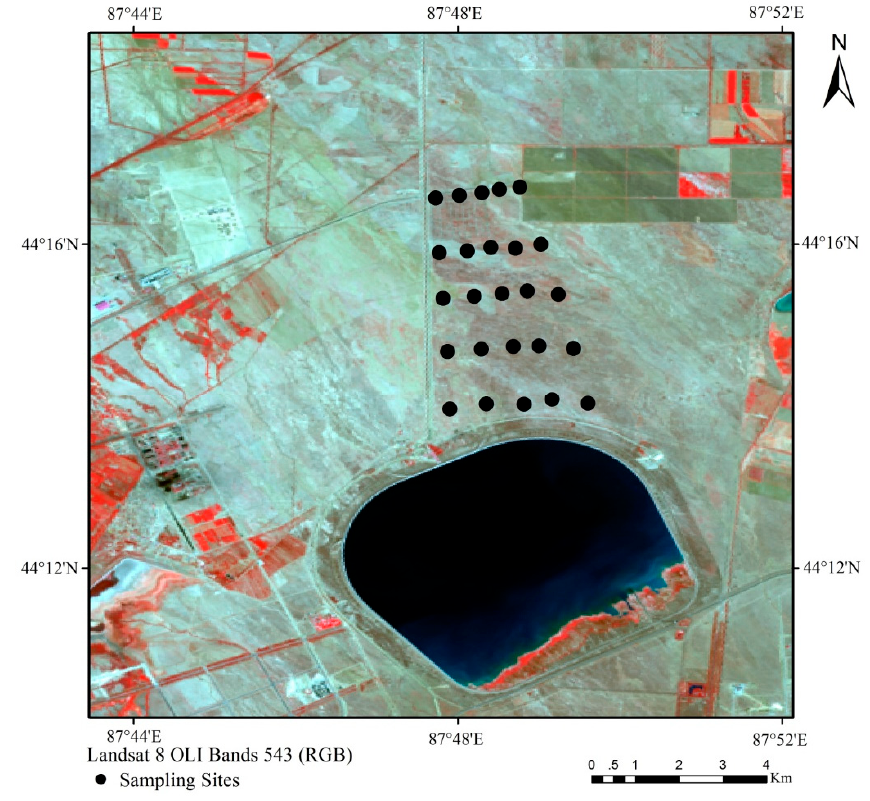
Figure 1. Location of sample point.